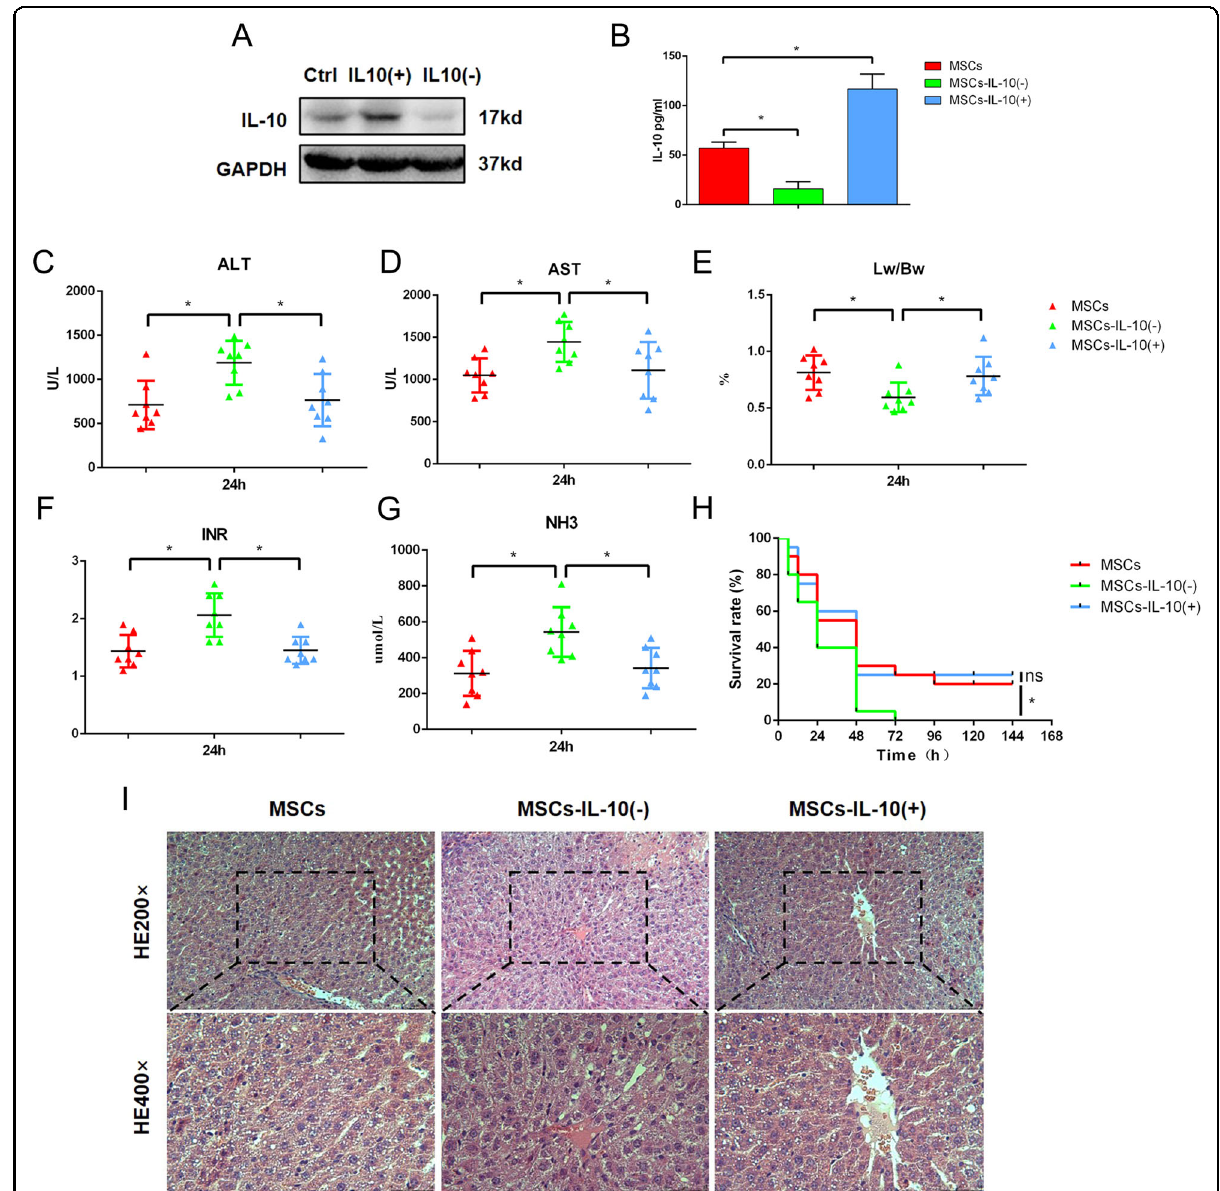
Fig. 6 The important role of IL-10 in MSCs transplantation. A , B Construction and veri fi cation of MSCs-IL-10( − ) and MSCs-IL-10( + ). C , D , F , G The levels of serum ALT, AST, INR, and ammonia were determined at 24 h. E Survival analysis of PHLF rats. H The ratio of liver to body weight. I Liver H&E staining. * P < 0.05. t -test, data are shown as mean standard